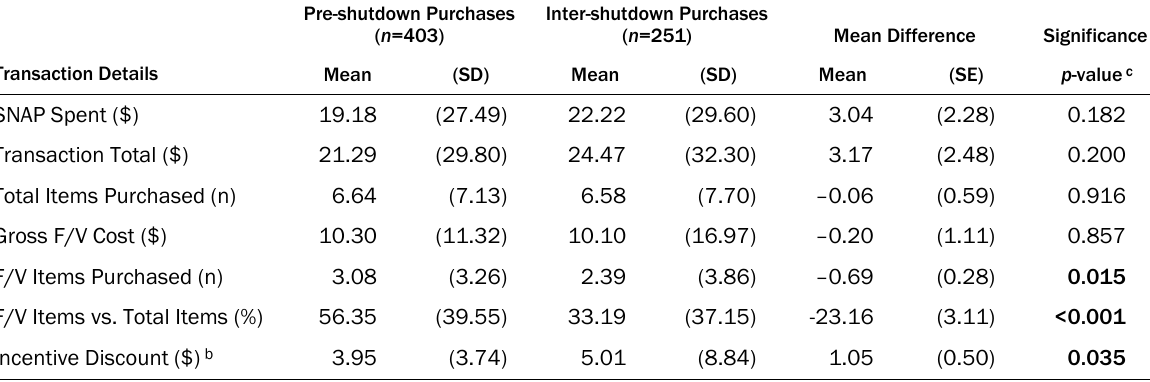
Table. Differences in SNAP Purchases made Pre-shutdown And Inter-shutdown Secondary to COVID-19 a